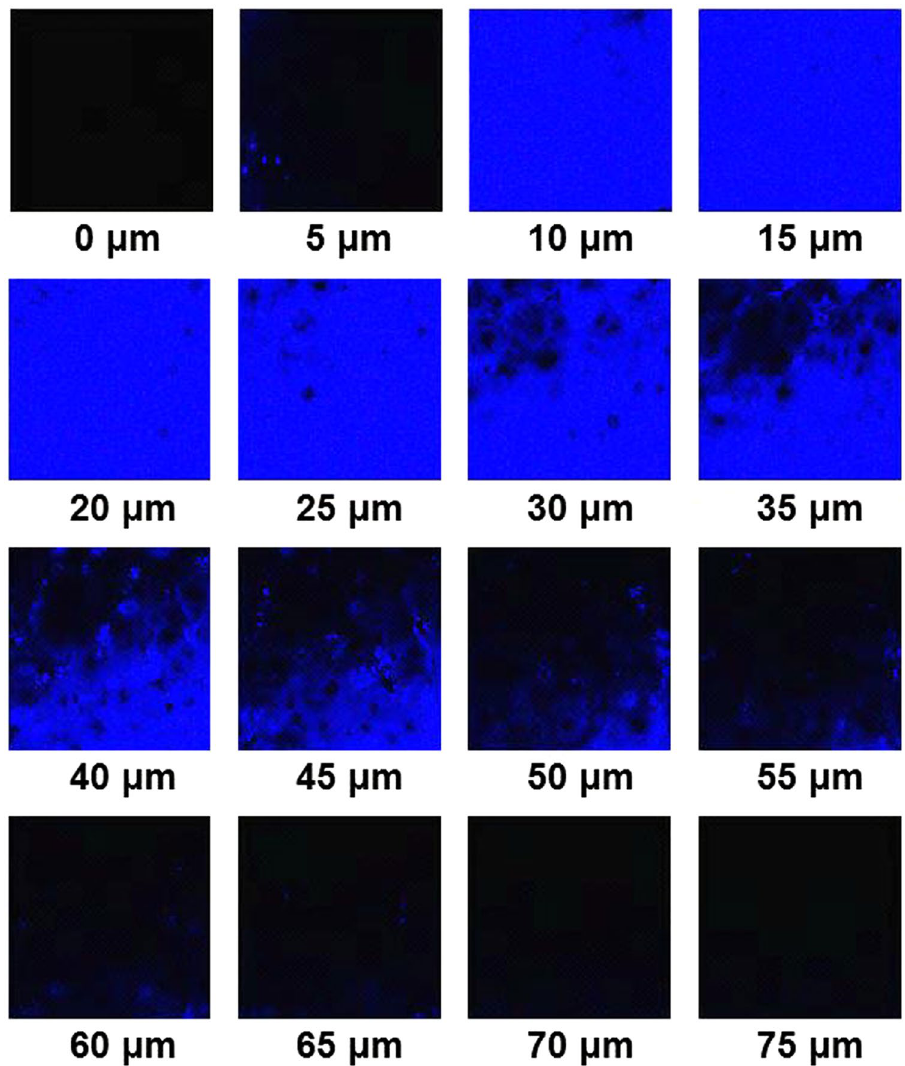
Figure 9. Two-photon fluorescence images of a fresh mouse liver slice pretreated with NS-N 2 H 4 (20 μ M) and then with